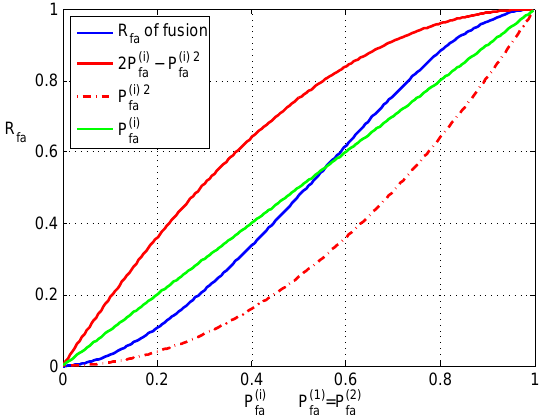
Figure 4. False alarm probability of fusion.